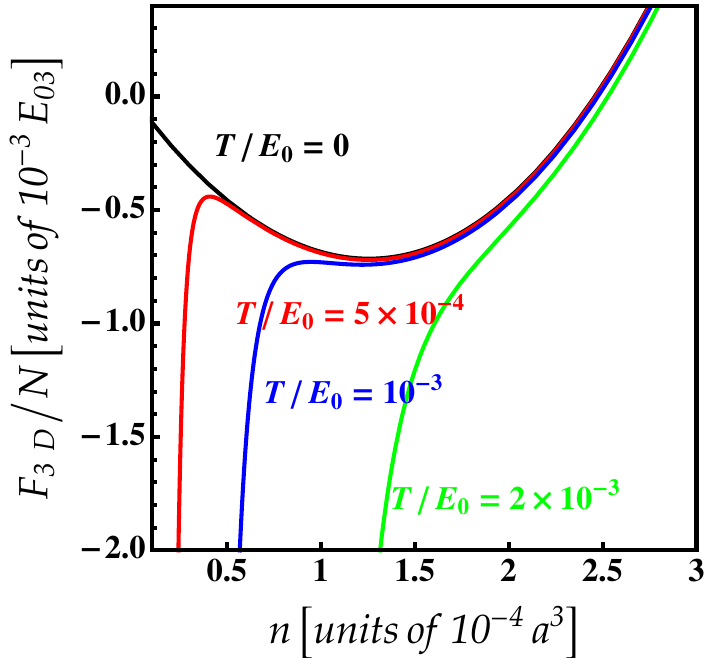
Figure 3. (Color online) Three-dimensional free energy up to the second order in ˜ m and ˜ n as a function of the density for a 12 = − 3 a at different values of